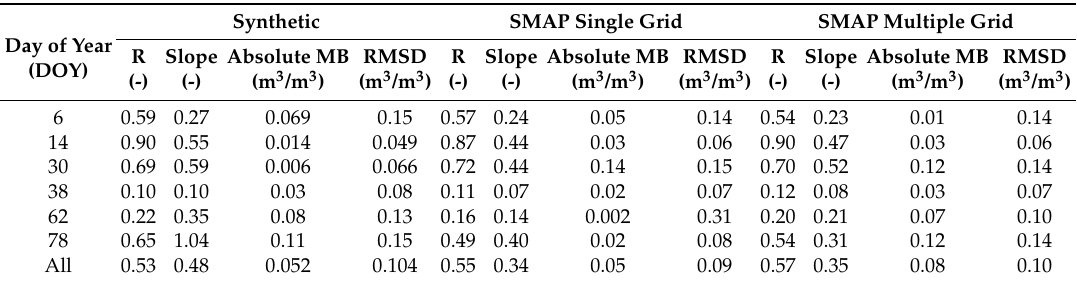
Table 1. Statistical results in terms of correlation coefficient (R), slope of the linear regression, absolute mean bias (MB) and root mean square difference (RMSD) between 100 m resolution disaggregated and in-situ SM for Synthetic, SMAP single grid and SMAP multiple grid LR SM cases separately (ISR is set to 10